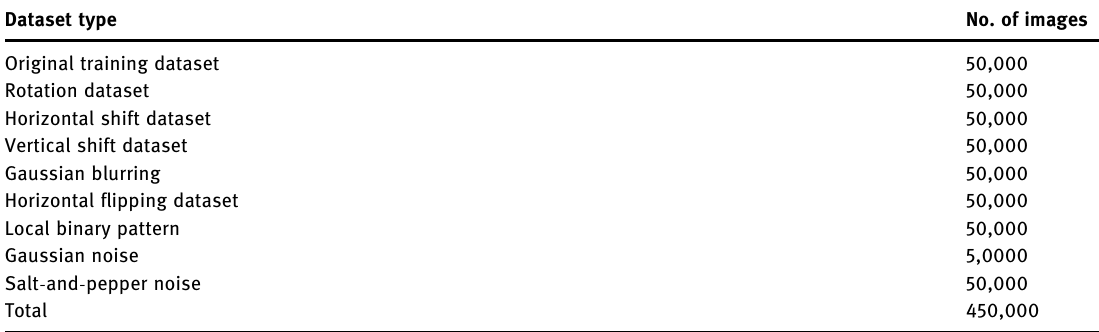
Table 4: Dataset size after applied data augmentation Dataset